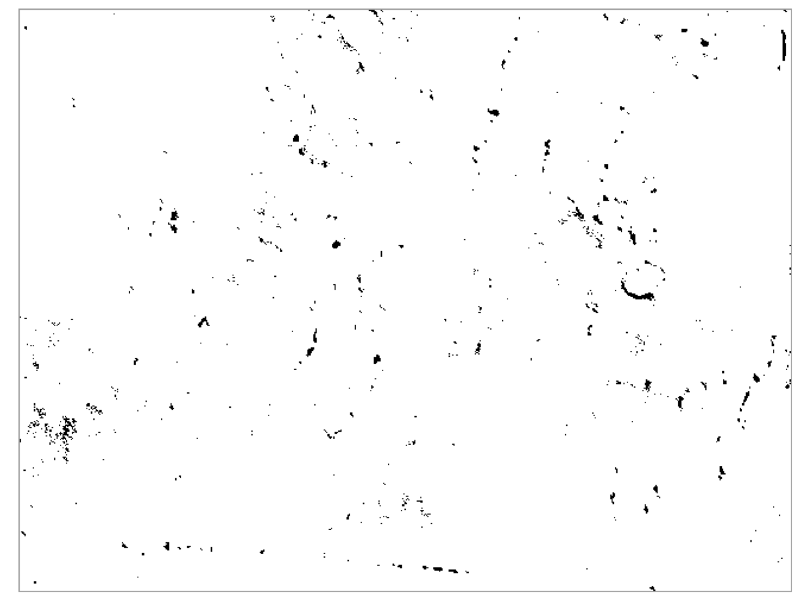
Fig. 6 Image processing results of digital image for the No. 8